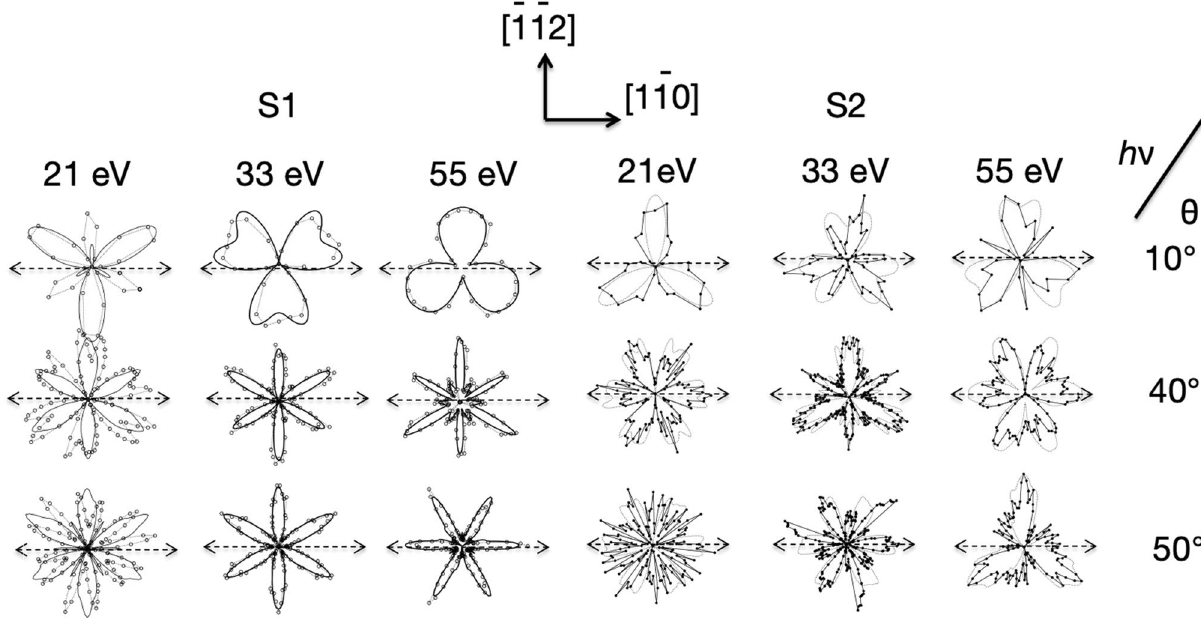
Figure 5. Normalised polar diagrams (at 10 ° , 40 ° and 50 ° polar angles) of the variation of photoemission intensity from the S1 and S2 surfaces state, obtained from the spectrum of photoemission intensity for a defined polar angle minus the minimum intensity value of this spectrum and divided by the difference between the maximum and minimum intensity values of this spectrum (Inormalised = (I − Imin)/(Imax − Imin)), as a function of azimuthal angle at several different photon energies (21 eV, 33 eV and 55 eV) and polar emission ϕ angles (at 10 ° , 40 ° and 50 ° polar angles). The experimental data, shown as individual data points joined by straight lines, are compared with the results of the MSC calculations shown as continuous